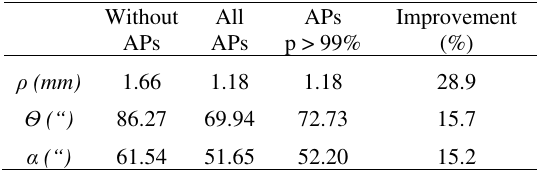
Table 7. A priori versus a posteriori accuracies achieved on the observables (without APs vs Adjustment